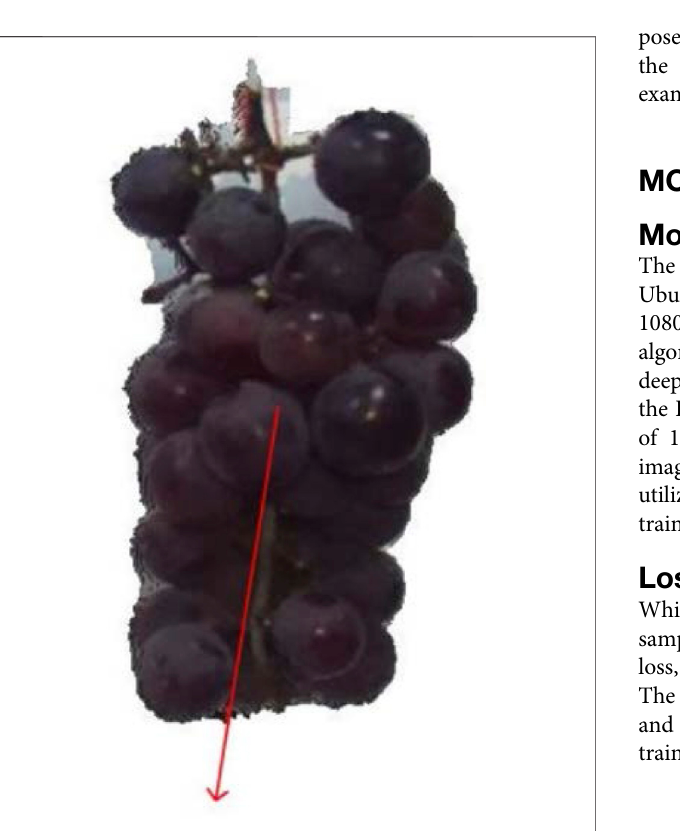
FIGURE 8 | Example of grape pose